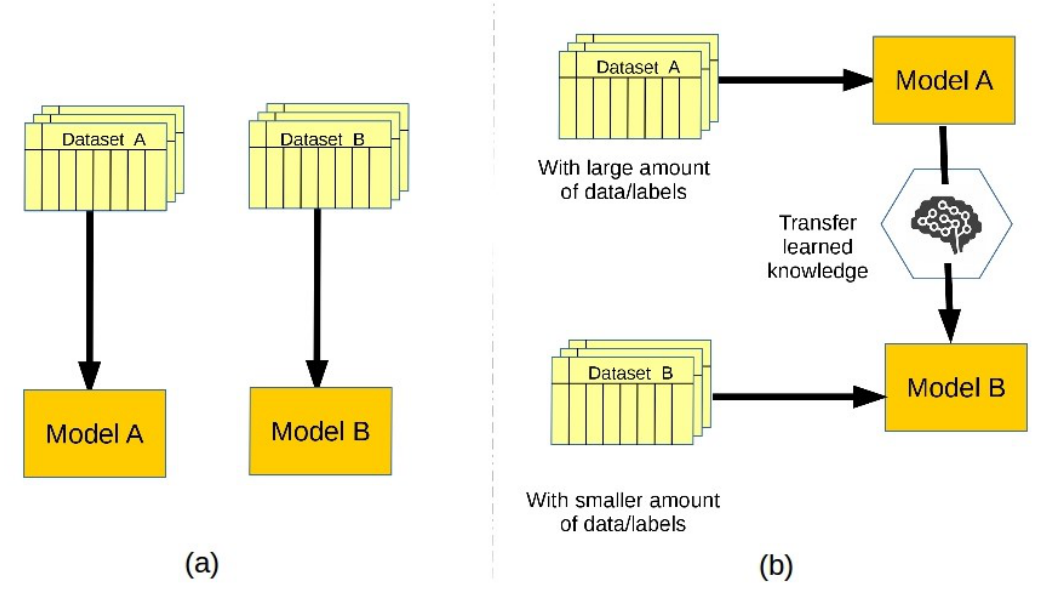
Figure 2. Representation of ( a ) traditional machine learning ( b ) transfer